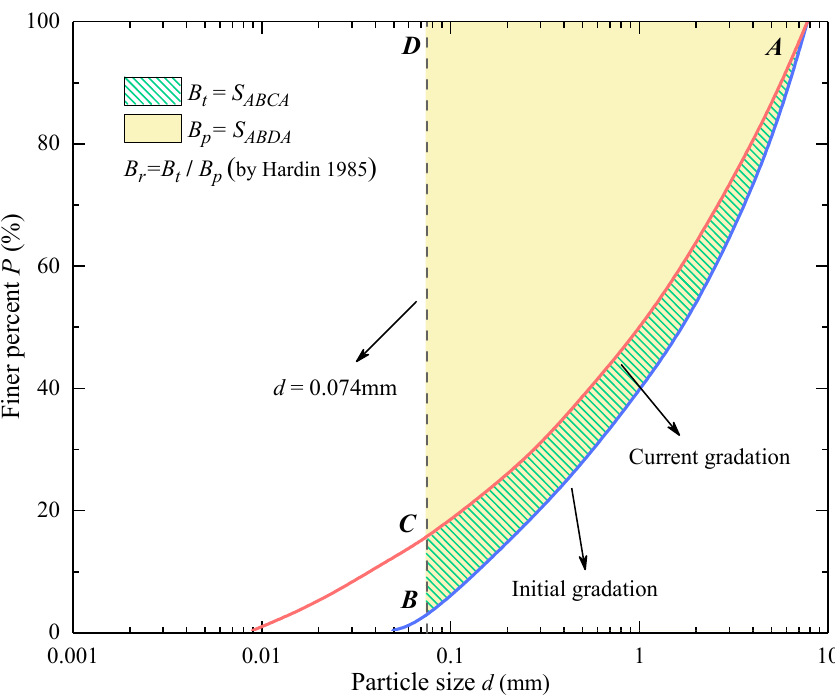
Figure 14. Calculated method of relative breakage ratio B r .